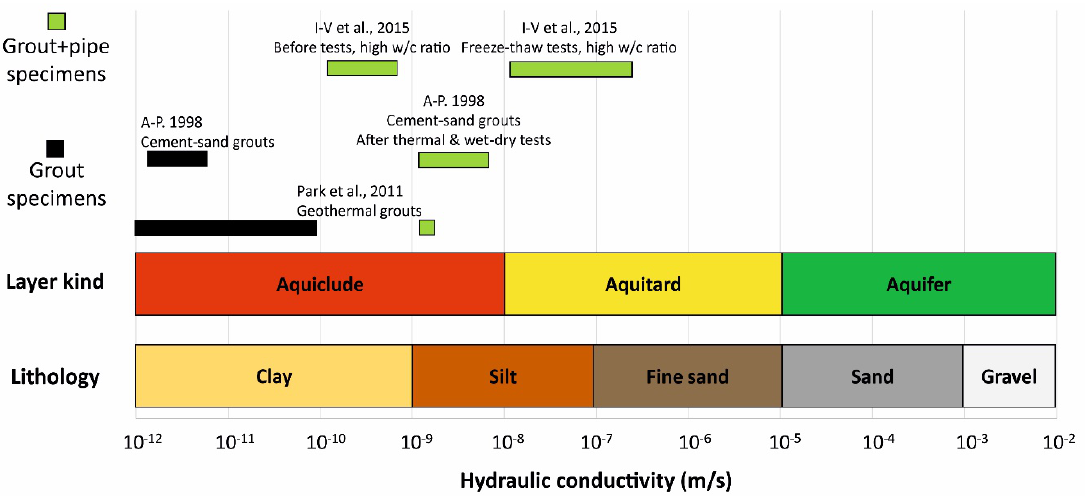
Figure 3. Comparison between hydraulic conductivities of geothermal grouts from laboratory tests (refer to the works of [21–23] for details of the references cited on the figure) and of typical aquifer, aquitard and aquiclude lithologies (see the works of [67]).